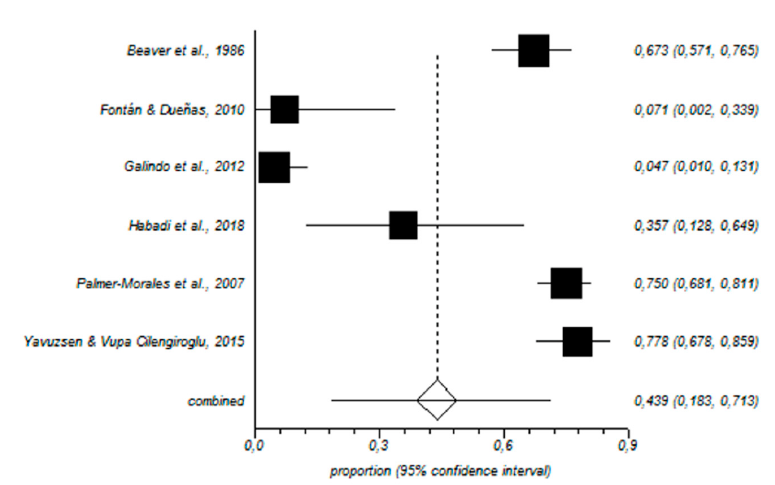
Figure 4. Forest plot for low personal accomplishment.